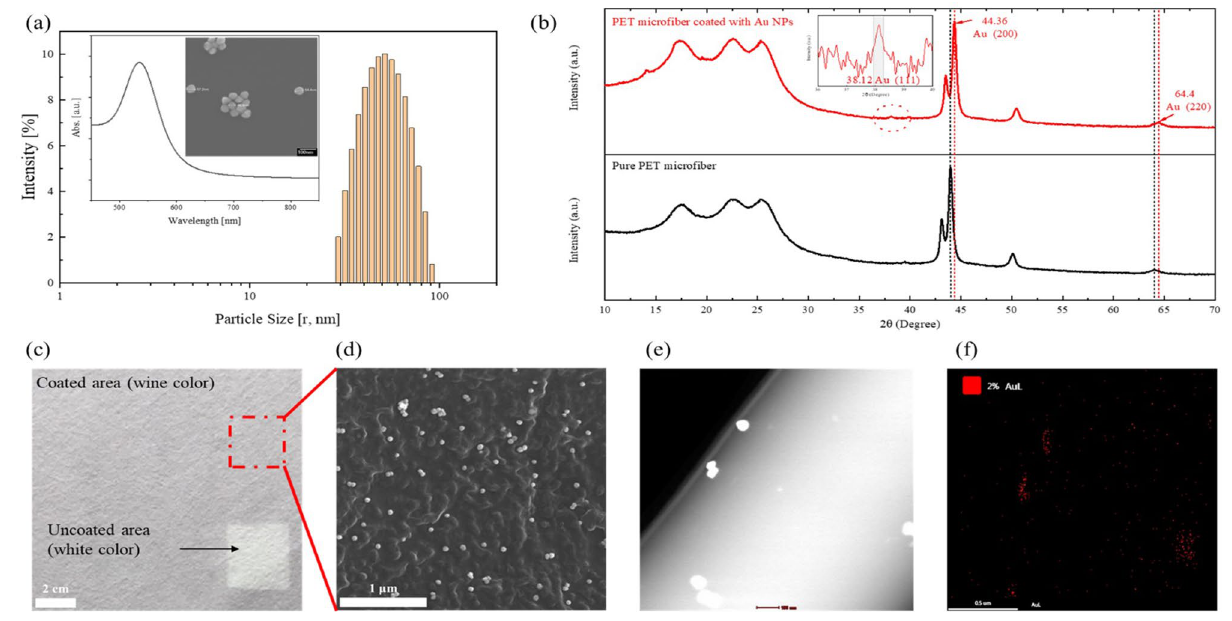
Figure 2. Characterization of the as-fabricated HFM. ( a ) Particle size, UV–Vis absorbance, and SEM image of the synthesized Au NPs. ( b ) XRD patterns of the PET microfiber with and without Au NPs. ( c ) Optical image of the HFM. ( d , e ) SEM and TEM image of the HFM coated with Au NPs. ( f ) TEM-EDS image of Au NPs on the PET